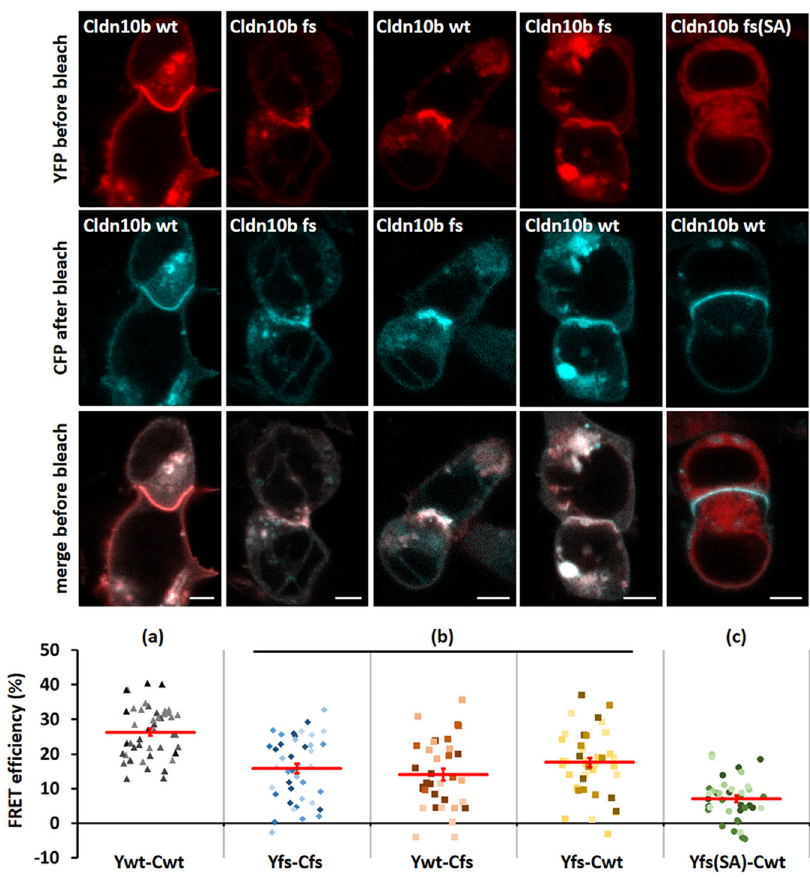
Fig. 7 | Claudin-10b wt and fs: subcellular distribution and FRET ef fi ciency. Upperpanels : co-transfection of YFP (red)and CFP(cyan)-tagged Cldn10bwt, fs, or fs(SA), respectively. The majority of wt – wt contacts were long and had a smooth appearance, whereas the majority of fs – fs contacts were short, and had an inter- rupted (dashed or ‘ ragged ’ ) appearance, likely due to claudin-10b within vesicles close to the plasma membrane rather than truly contact-enriched claudin-10b. Cldn10bwt co-localizedwith claudin-10bfs incell – cell contacts (merge);however, these contacts had an appearance similar to the contacts observed in cells expressing only Cldn10b fs. As previously described (Alzahrani et al., 2021), Cldn10b fs(SA) did not insert into the plasma membrane but was retained in intracellularcompartments(endoplasmicreticulum).Theco-expressedCldn10bwt was unaffected by the presence of Cldn10b fs(SA). Cell – cell contacts had a wt-like